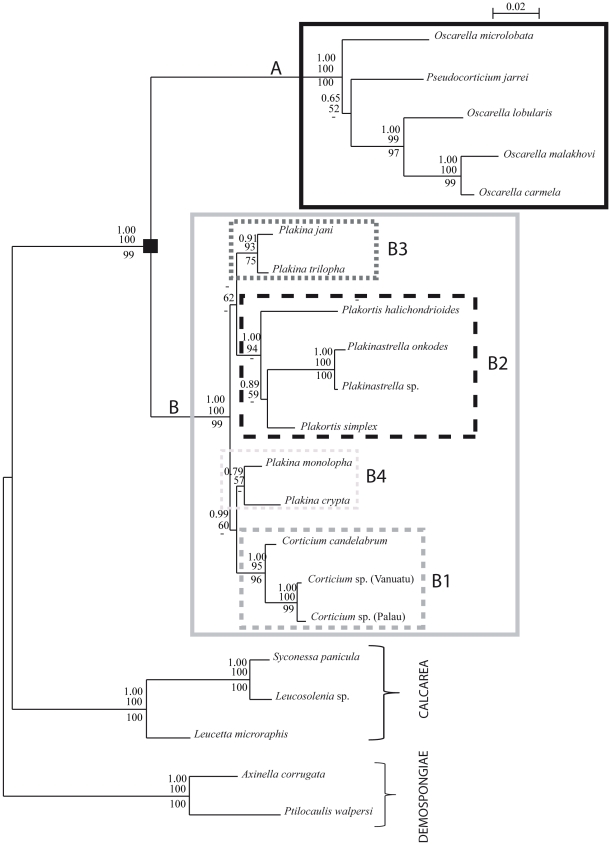
Phylogram showing the relationships among the six genera of Homoscleromorpha based on 18S rDNA analyses.The topology presented corresponds to the ML analysis. Outgroups are Calcarea (AM180965, AM180976, AF100945) and Demospongiae (AY737637, AY737638) species. The Homoscleromorpha species are split into two robust clades: A and B. The numbers are from top to bottom: posterior probabilities for BI and bootstrap values (>50) for ML and MP respectively. Bayesian and MP analyses recovered slightly different phylogenies (Fig. S2). The black square points out the node corresponding to Homoscleromorpha.